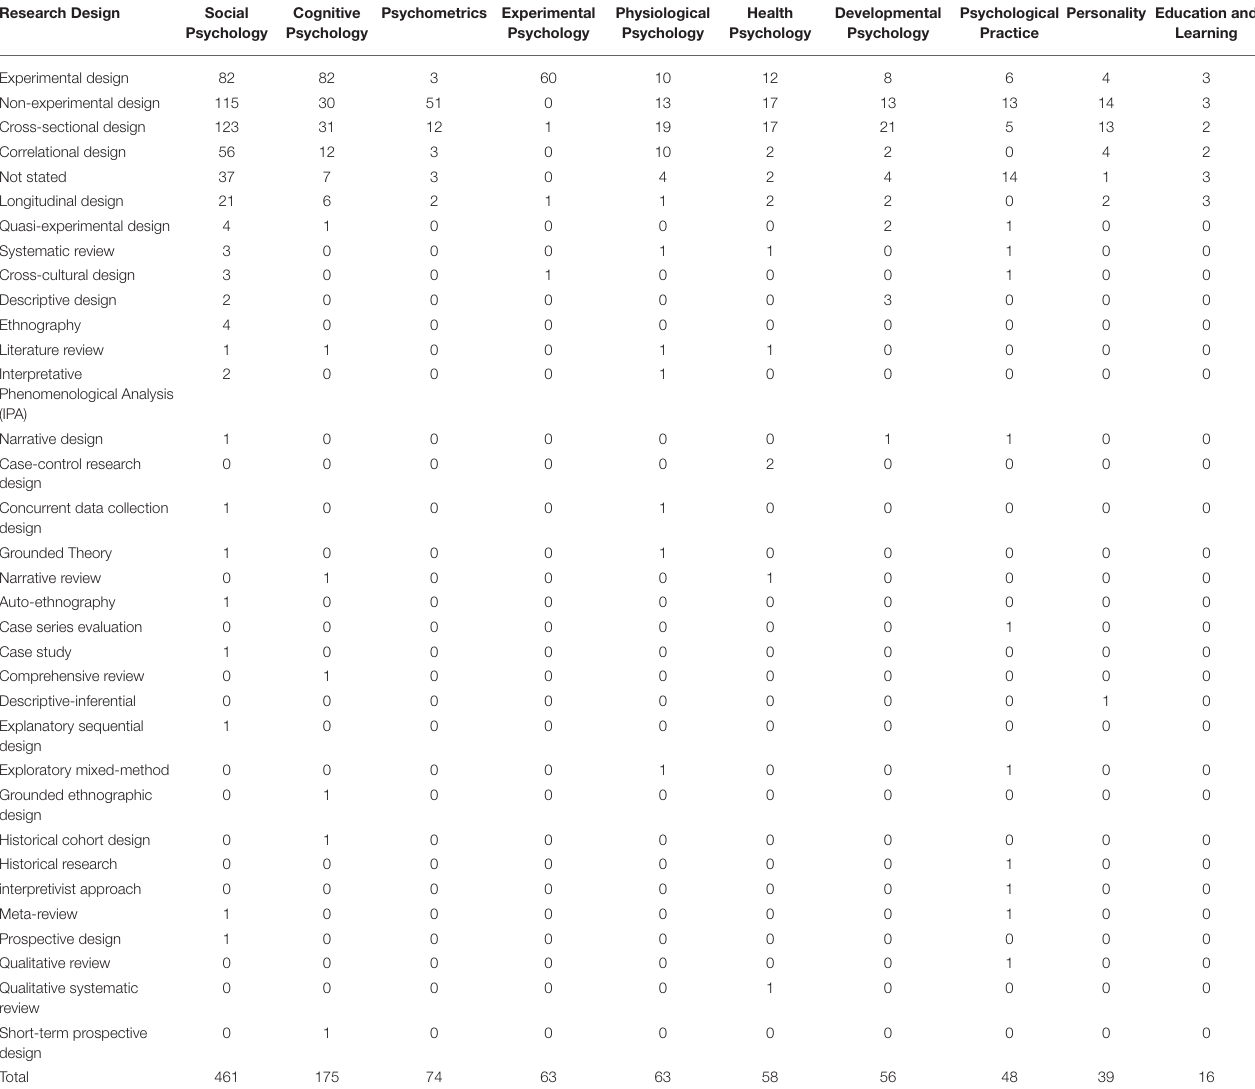
TABLE 4 | Design use in the field of psychology. Research Design